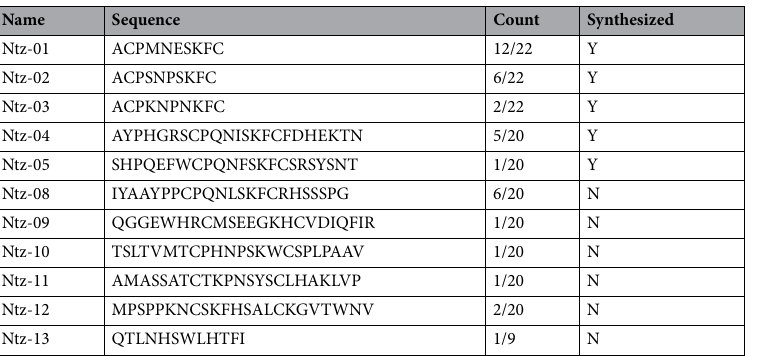
clones, listed in Table 2. A primary sequence motif, shown in Fig. 1a,b, emerged from the cysteine-constrained sequences. Five peptides displaying the motif were synthesized and tested as capture reagents in ELISA on neutravidin- or streptavidin- coated plates. All five peptides bound natalizumab (Fig. 1c) and demonstrated spec- ificity when screened against three control mAb therapeutics (Fig. 1d). Ntz-01 peptide was selected for further testing, due to the highly conserved sequence of Ntz-01, -02, and -03 and lack of adjacent random sequence (as in Ntz-04 and Ntz-05). Additional selectivity of Ntz-01 was confirmed by binding natalizumab in 0.1-1% serum (Fig. 1e). No matrix effects were observed in this serum concentration range. The epitope of Ntz-01 was characterized by competition with α 4 integrin binding to natalizumab. A series of Ntz-01 concentrations were mixed with natalizumab prior to incubation with CD49d + ( α 4 integrin) JeKo-1 cells. Cell-bound natalizumab was detected by fluorescently labeled secondary antibody and quantified by flow cytometry. Concentration dependent Ntz-01 inhibition of natalizumab-cell binding was observed (Fig. 2a). In competition ELISA, Ntz-01 inhibition of natalizumab capture by a neutralizing anti-idiotype (anti-Id) antibody Fab fragment was also observed (Fig. 2b). Confirmation of JeKo-1 cell CD49d expression is shown in Online Resource 1 (Supplemental Fig. 1). Stability of natalizumab binding under harsh conditions was assessed by exposing natalizumab-spiked serum samples to heat for various lengths of time. The reducing agent GSH was used to simulate in vivo natalizumab arm exchange as reported elsewhere (Labrijn et al . 2009). Split GSH and non-GSH treated natalizumab-spiked serum samples were incubated at 60 °C for 30 m, 1 h, or 2 h. Control samples were held at 4 °C. Functional binding of the heated natalizumab was assessed by incubating the heat exposed samples with JeKo-1 cells. Cell-bound natali- zumab was detected by fluorescently labeled secondary antibody and quantified by flow cytometry. Decreased cell binding was observed with increased heat exposure for both GSH and non-GSH treated samples (Fig. 3a). The heat exposed samples were also assayed by Ntz-01 peptide ELISA and anti-Id ELISA (Fig. 3b). Decreased binding was observed with increased heat exposure by Ntz-01 peptide ELISA, particularly for the GSH treated samples. Changes in binding with heat exposure were not observed by anti-Id ELISA for either GSH or non-GSH treated samples. To identify high affinity motifs, Ntz-01, Ntz-02, and Ntz-03 underwent affinity maturation mutagenesis. Single amino acid substitutions and deletions were done at each random position of the three peptides while main- taining the disulfide constraint. Substitutions were scanned across 18 of the 20 natural amino acids, excluding methionine and cysteine. All peptide variants were tested for natalizumab binding. Linear versions of the parent sequences were also tested but did not bind natalizumab (data not shown). Substitution and deletion results for each sequence are graphically represented in Fig. 4a. The x-axis represents the parent amino acid sequence and the y-axis represents natalizumab binding in arbitrary ELISA units (mAU). Substitutions and deletions at each residue are plotted to indicate natalizumab binding for that substitution (single-letter amino acid nomencla- ture). The red line indicates natalizumab binding to the parent peptide. Sequence motifs PKNPSKF, PRNPSKF, PQNPSKF, and PRNESKF showed increased binding relative to the parent sequences. From this data, two pep- tides, Ntz-06 and Ntz-07, were synthesized (Table 3) and assessed as capture reagents in ELISA. Both peptides bound natalizumab with higher apparent affinities than the original peptides (Fig. 4b). Ntz-06 was improved